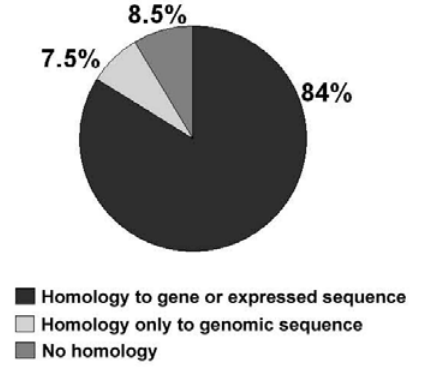
FIGURE 2. Of the differentially expressed transcripts, 91.5% shared similarity with known genes; 695 of the 829 differentially expressed transcripts (84%) were similar to known genes; 63 (7.5%) showed homology only to genomic sequences, but not to known genes; 71 (8.5%) contained no significant homology to cDNAs or genomic